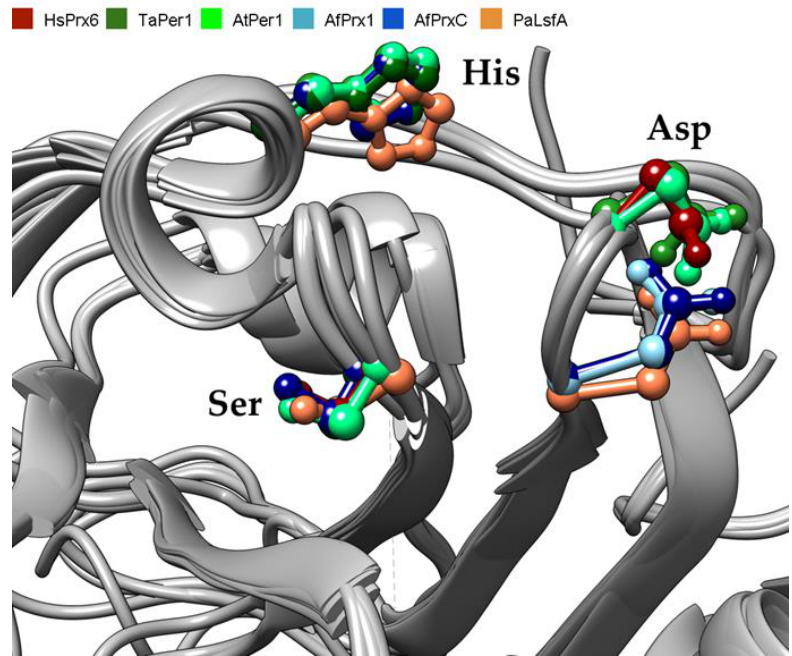
Figure 4. Close view of the PLA 2 catalytic triad of six 1-Cys Prdxs from H. sapiens (red), T. aestivum (dark green), A. thaliana (light green), A. fumigatus (Prx1 in light blue and PrxC in dark blue), and P. aeruginosa (orange) superimposed.